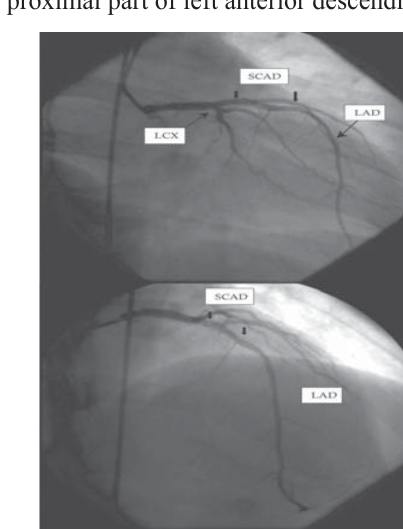
Fig 2. Coronary angiogram showing spiral shaped coronary artery dissection (white arrows) at proximal part of left anterior descending artery